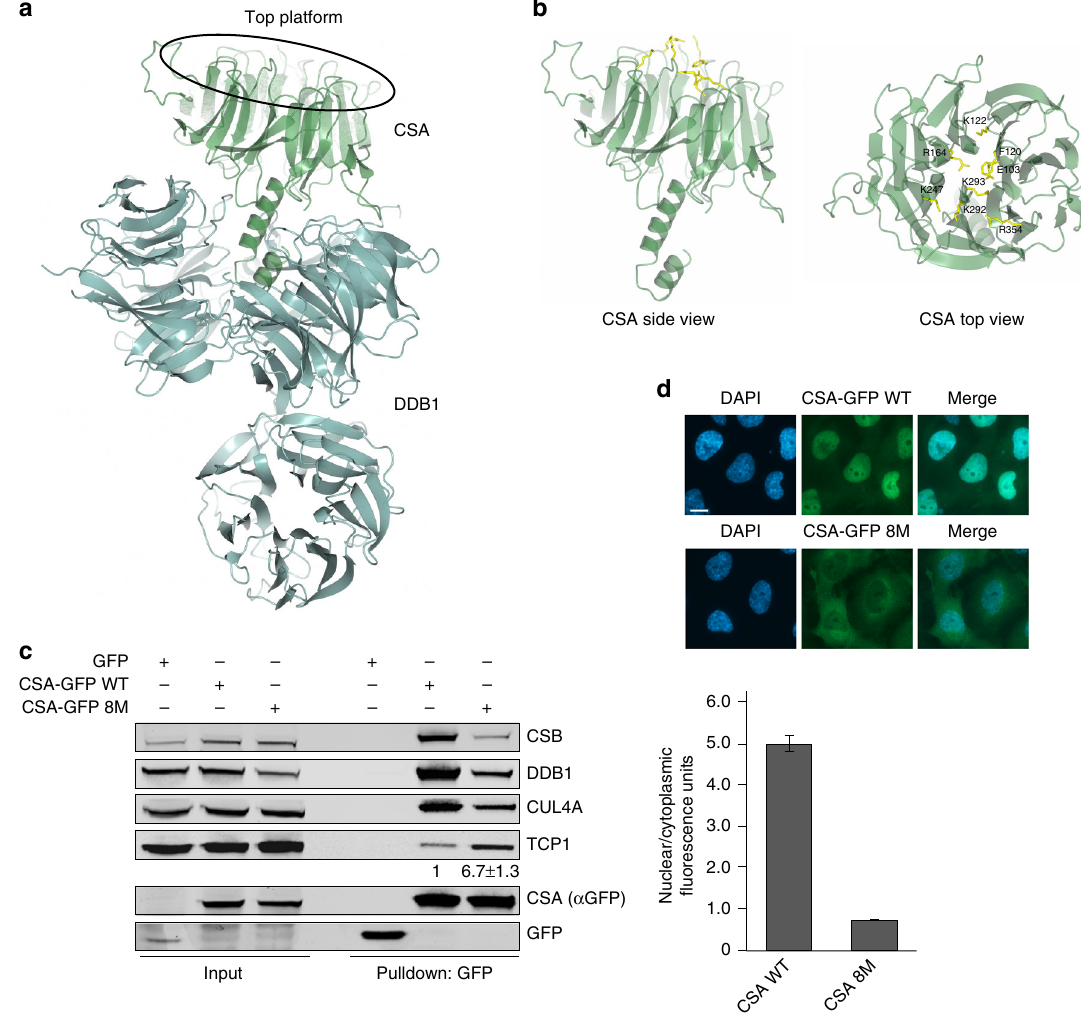
Fig. 5 A CSA mutant of the top platform shows increased TRiC binding. a Overall structure of CSA (green) bound to DDB1 (blue), showing that not CSA ’ s top platform, but its N-terminus is directly involved in DDB1 binding. Visualization was done in ccp4mg using structure 4a11 from the PDB. b Side and top view of CSA. The amino acids Glu103, Phe120, Lys122, Arg164, Lys247, Lys292, Lys293, and Arg354 in CSA ’ s top platform that were mutated to Alanines in the CSA 8M mutant are shown in yellow. c The CSA 8M mutant shows decreased incorporation into the CRL CSA complex, but increased TCP1 binding. CSA-GFP WT and CSA-GFP 8M were pulled down from CS3BE-SV40 cells. Protein levels were determined by western blot analysis of the indicated proteins. The ratio of TCP1 signal intensity over CSA-GFP 8M relative to that of TCP1 over CSA-GFP WT, which was set to 1, is shown as the mean ± SEM of two independent experiments. d CSA-GFP 8M shows reduced protein abundance in the nucleus concomitantly with an increase in cytoplasmic localization. Mean nuclear and cytoplasmic GFP levels were analyzed and quanti fi ed by fl uorescence microscopy and ImageJ. For each cell the nuclear/ cytoplasmic ratio was calculated. Data represent mean ± SEM of 160 cells quanti fi ed in two independent experiments. Length of scale bar: 10 µ m. Full-size scans of western blots are provided in Supplementary Fig.